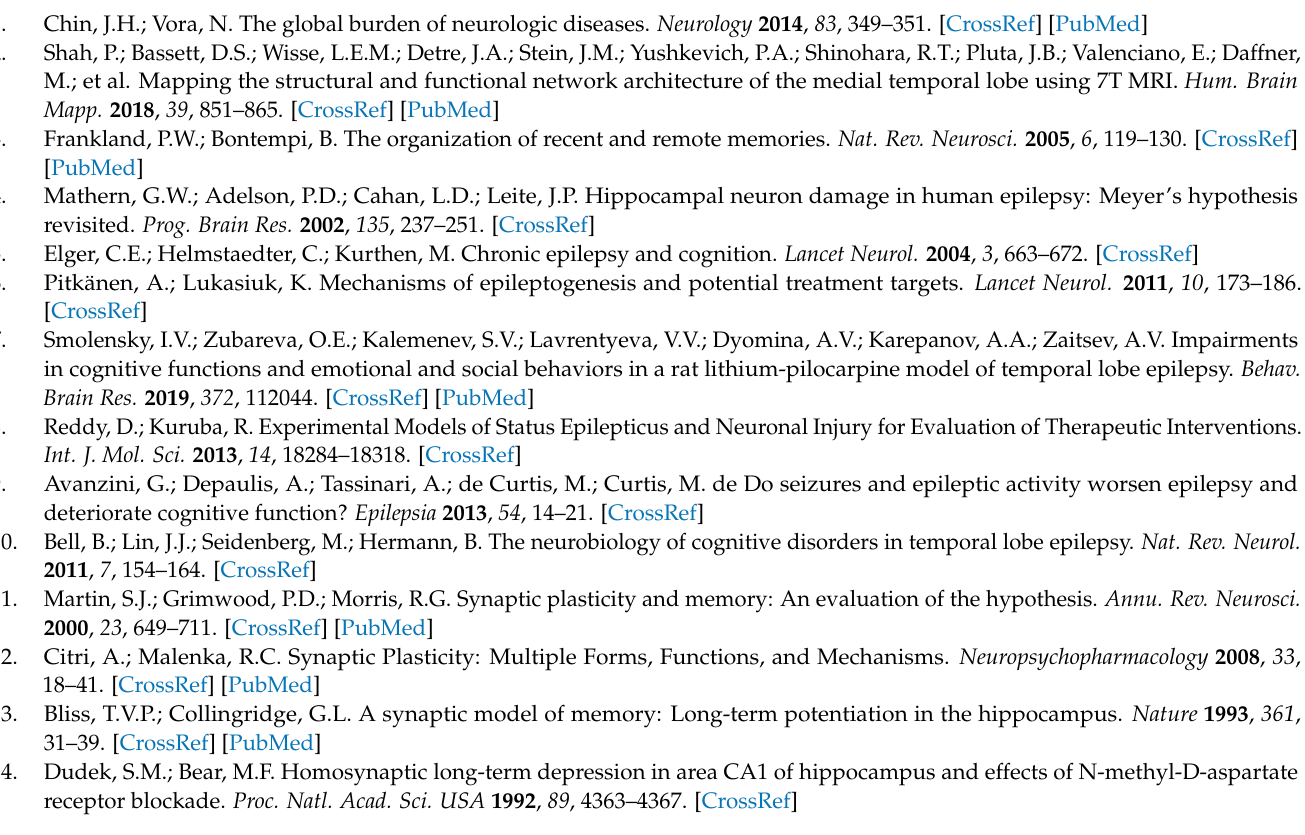
Figure A2. LTP values in the CA1 hippocampal area are the same in control rats at ages P22 and P29. Representative examples of fEPSP were recorded before induction (1) and 50–60 min after HFS (2). The diagram on the left is showing the normalized slope of fEPSP in control rats of two ages. The bar diagram illustrates no differences in LTP value between groups ( t -test = 0.41, p = 0.70; P22: n = 8; P29: n = 7) The diamonds show the individual values for each brain slice. Data are presented as a mean ± standard error of the